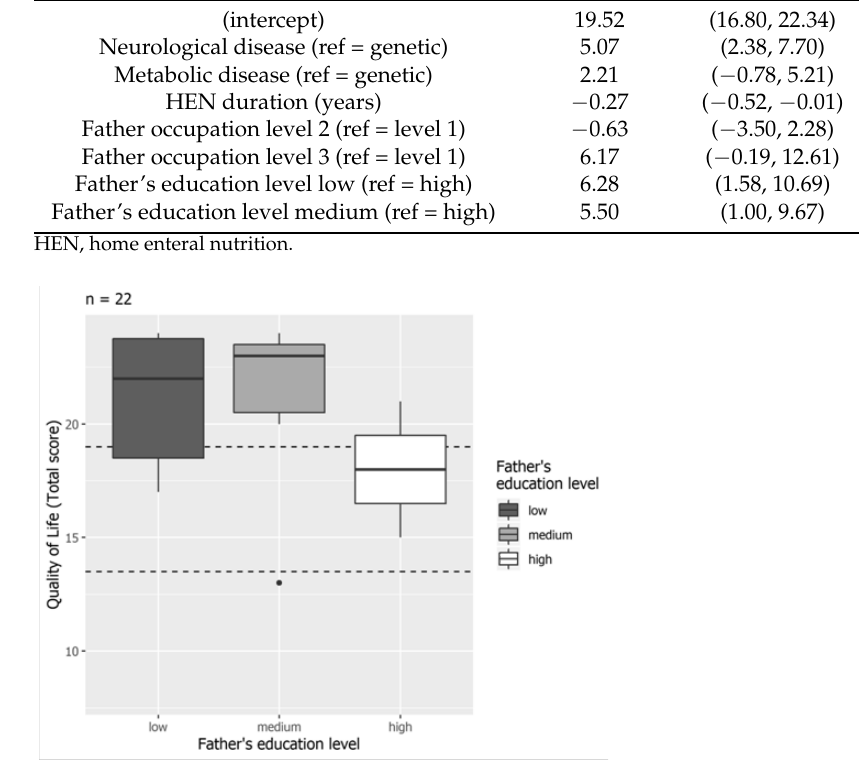
Figure 2. Health-related quality of life and education level of fathers in the subgroup of children with both parents as